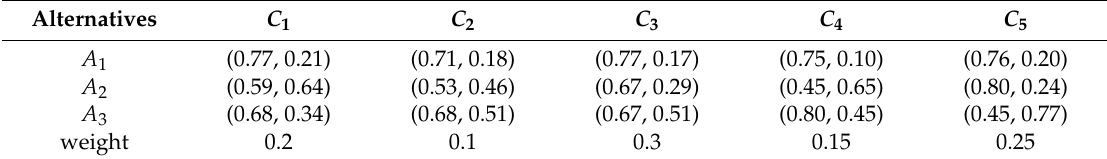
Table 10. The collective evaluation matrix of R&D project regarding each criterion [11].